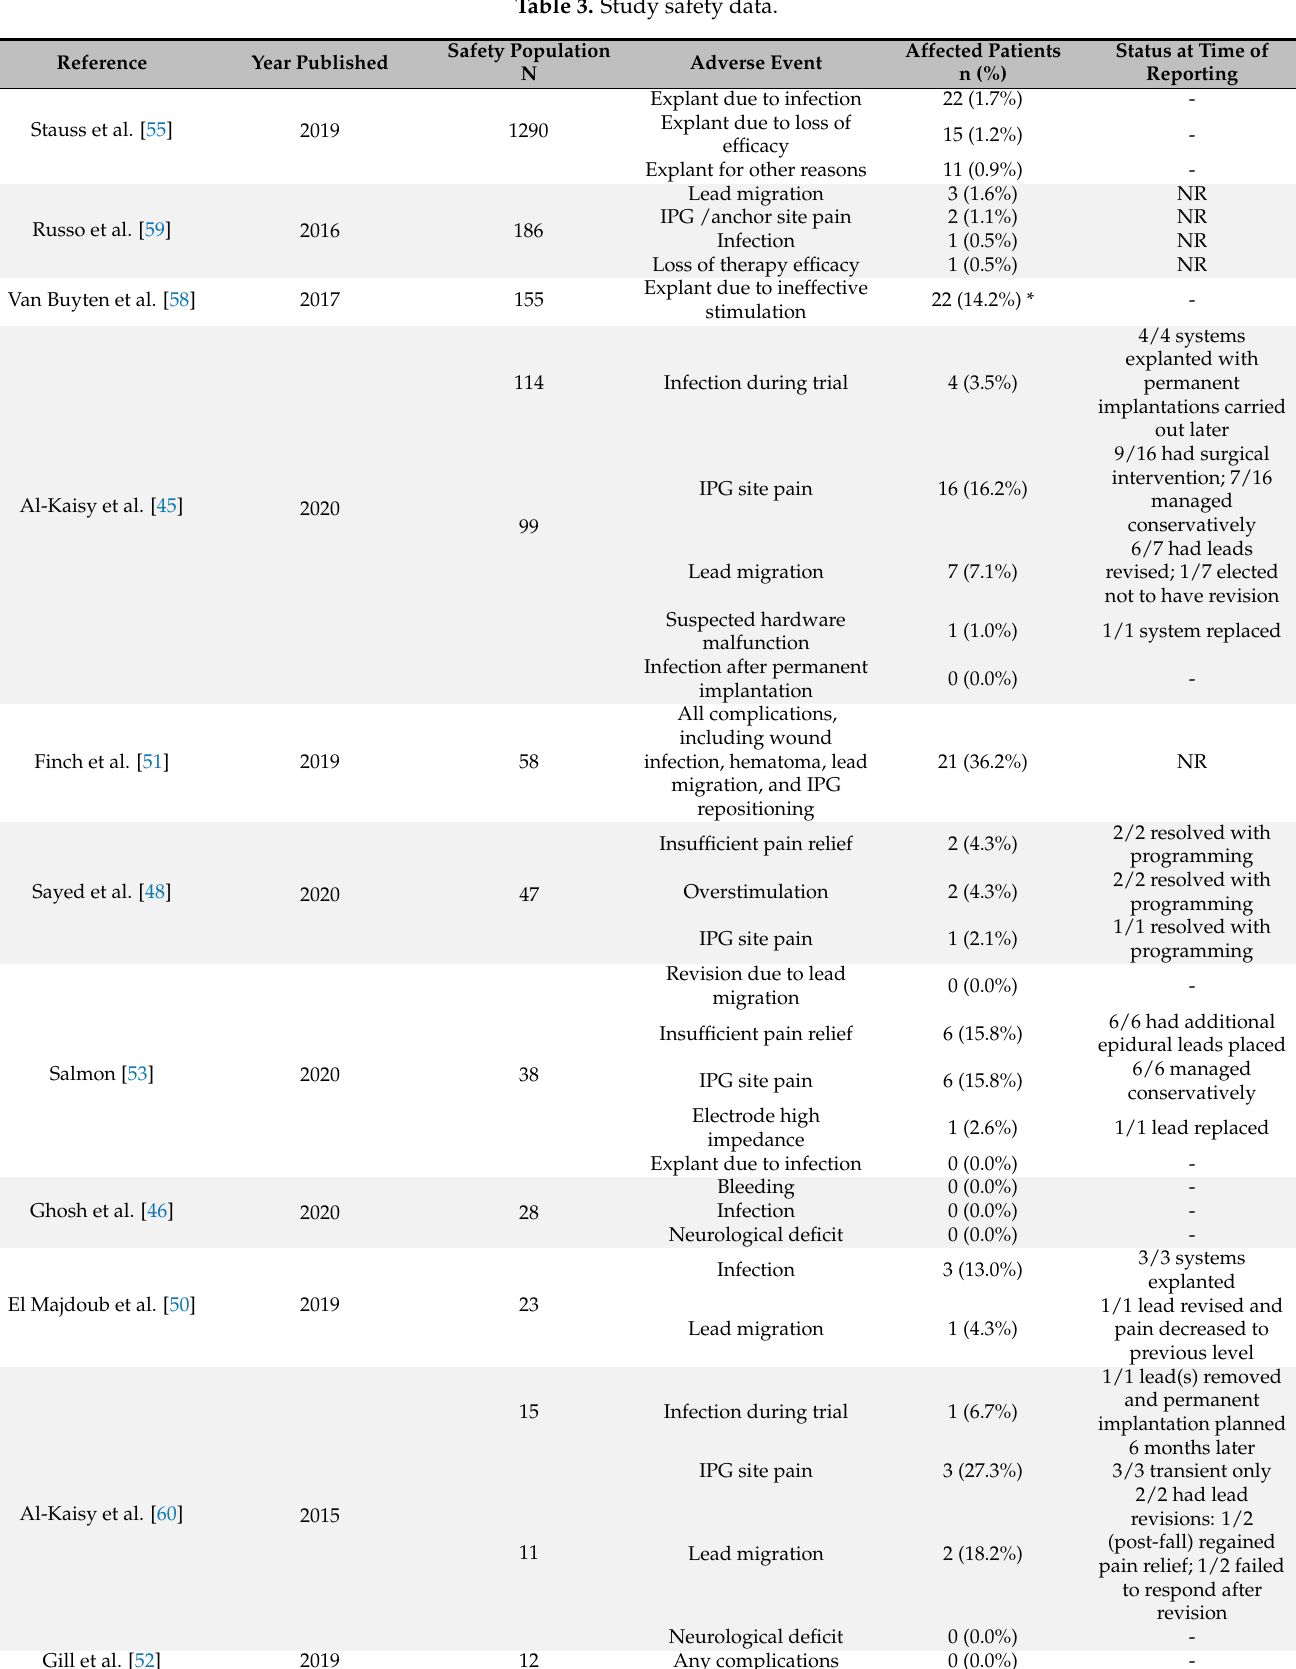
Table 3. Study safety